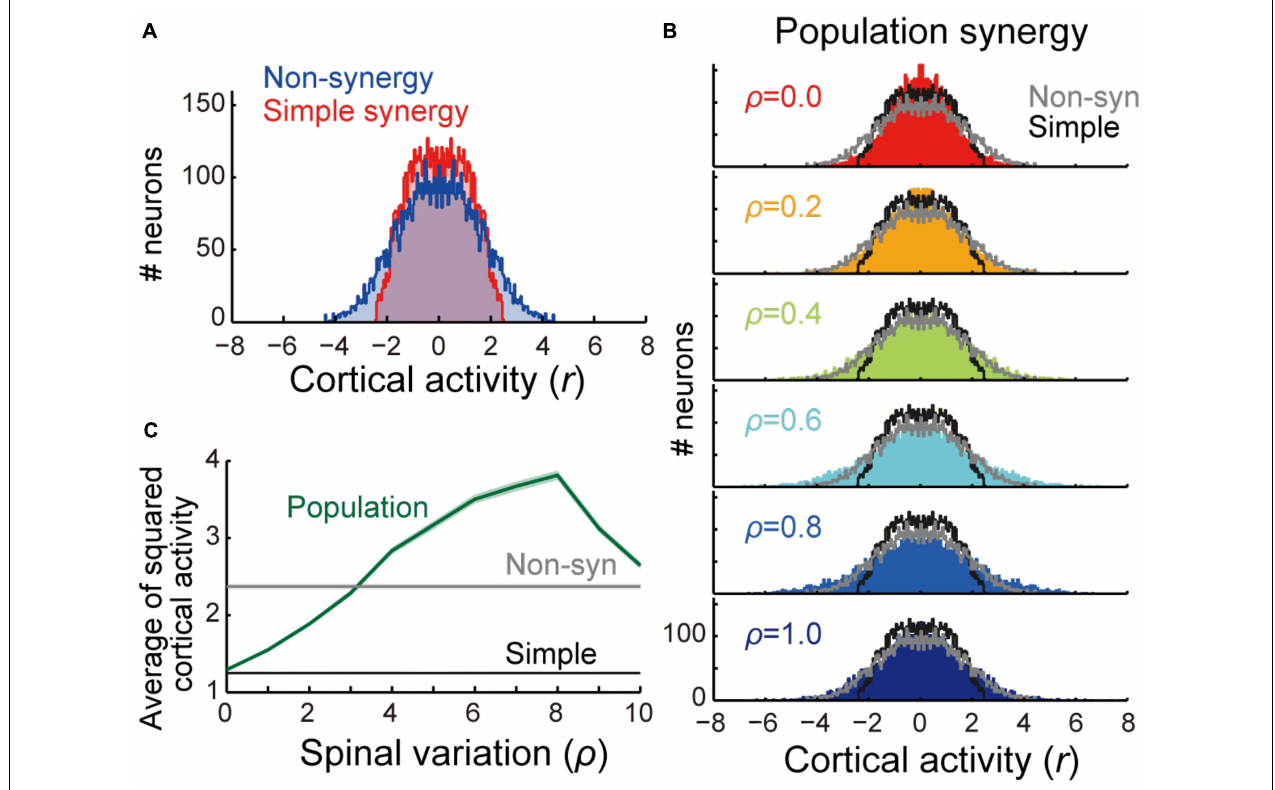
FIGURE 3 | Comparison of cortical activity between models. (A) Distribution of cortical activity of non-synergy (blue) and simple synergy model (red). Activity of cortical neurons ( n = 1,000) was pooled for 8 target locations ( n = 8,000). (B) Comparison of cortical activity between population synergy model with different spinal variation ( ρ ) with non-synergy (gray) and simple synergy (black) models. (C) Mean squared cortical activity of population synergy model (blue) with different spinal variation ( ρ ) in comparison with non-synergy (gray) and simple synergy (black) models. Line and shade, mean and standard error of mean across pooled neurons ( n =